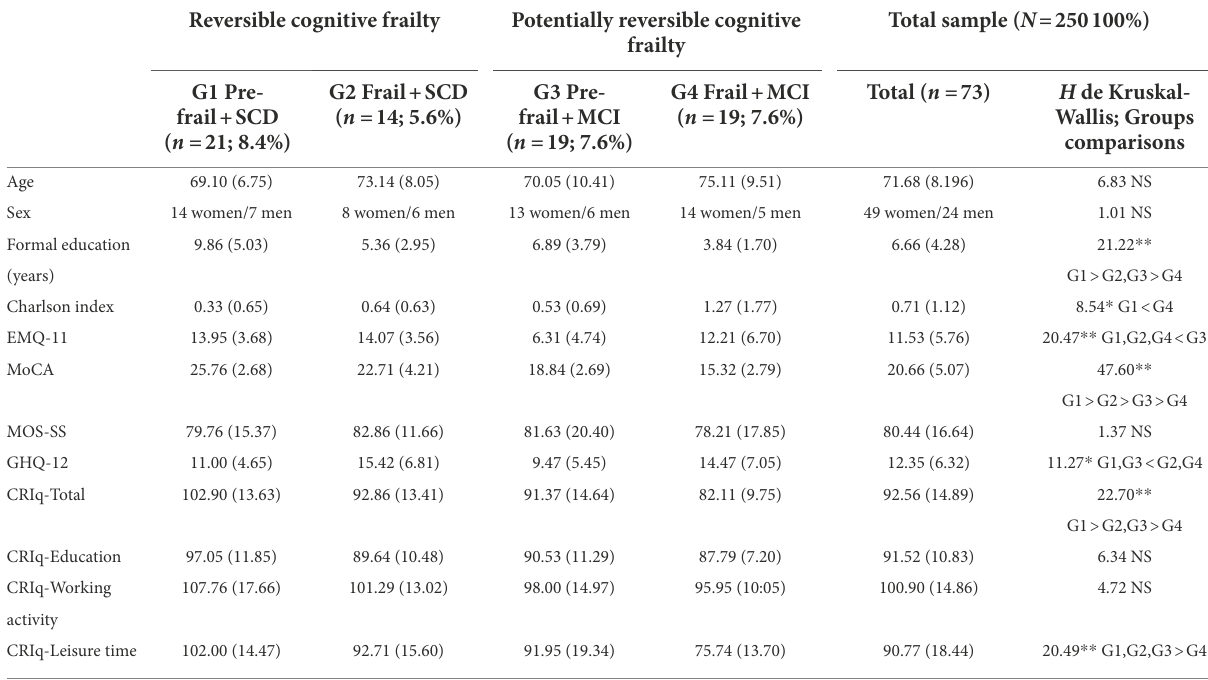
TABLE 2 Cognitive frailty